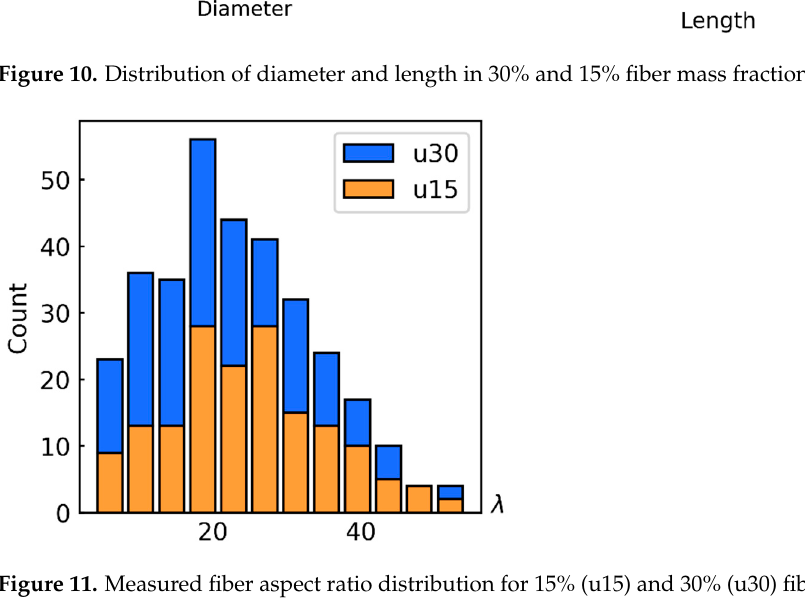
Figure 11. Measured fiber aspect ratio distribution for 15% (u15) and 30% (u30) fiber mass